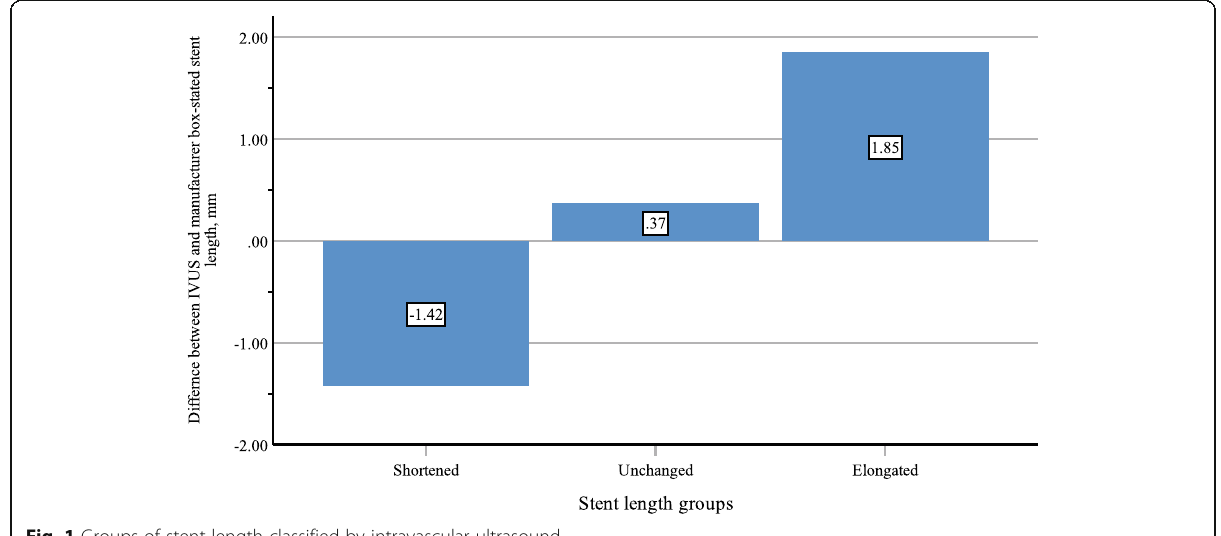
Fig. 1 Groups of stent length classified by intravascular